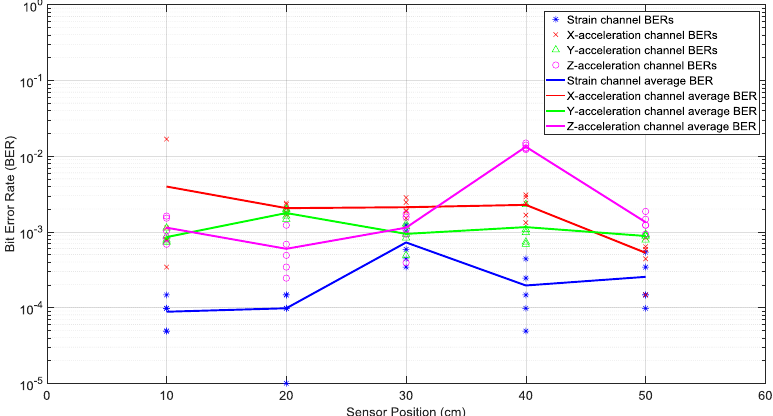
Figure 4. Bit error rates of various receiving sensors at different positions, with one actuator transmitting one data stream. The receivers were a strain sensor and a triaxial accelerometer with x , y , and z channels. The piecewise linear graphs represent the average BERs of each sensor versus the sensor position.